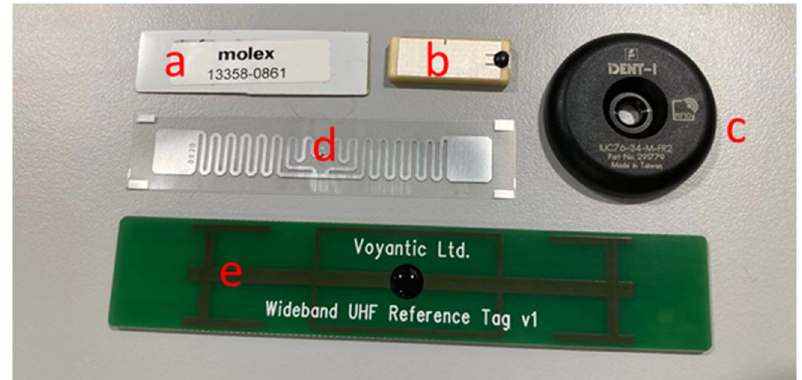
Figure 6. Experiment setup for RFID-based sensing system. Table 2. Specifications of selected transponders.